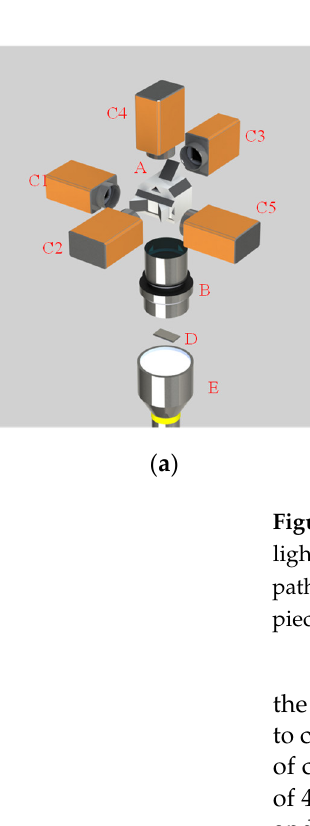
Figure 4. Prisms merge the light.